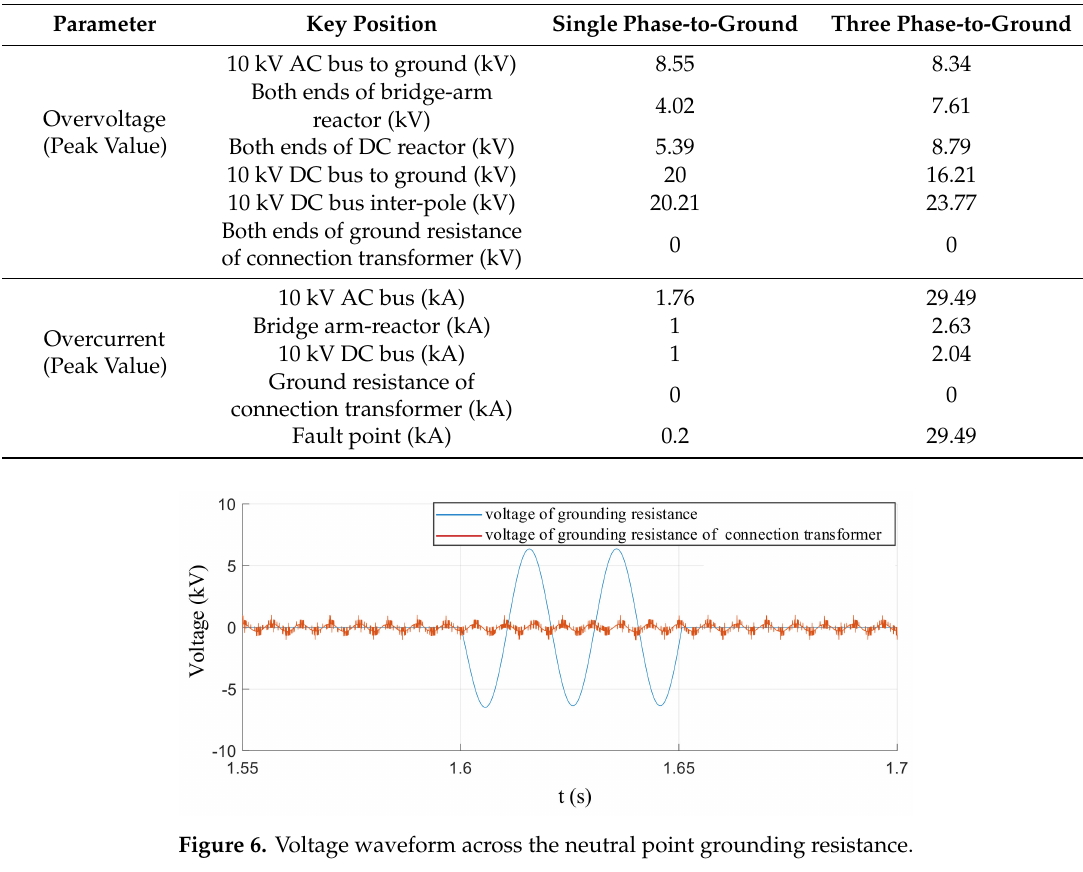
Table 5. Overvoltage and overcurrent levels during the 10 kV AC system side fault.